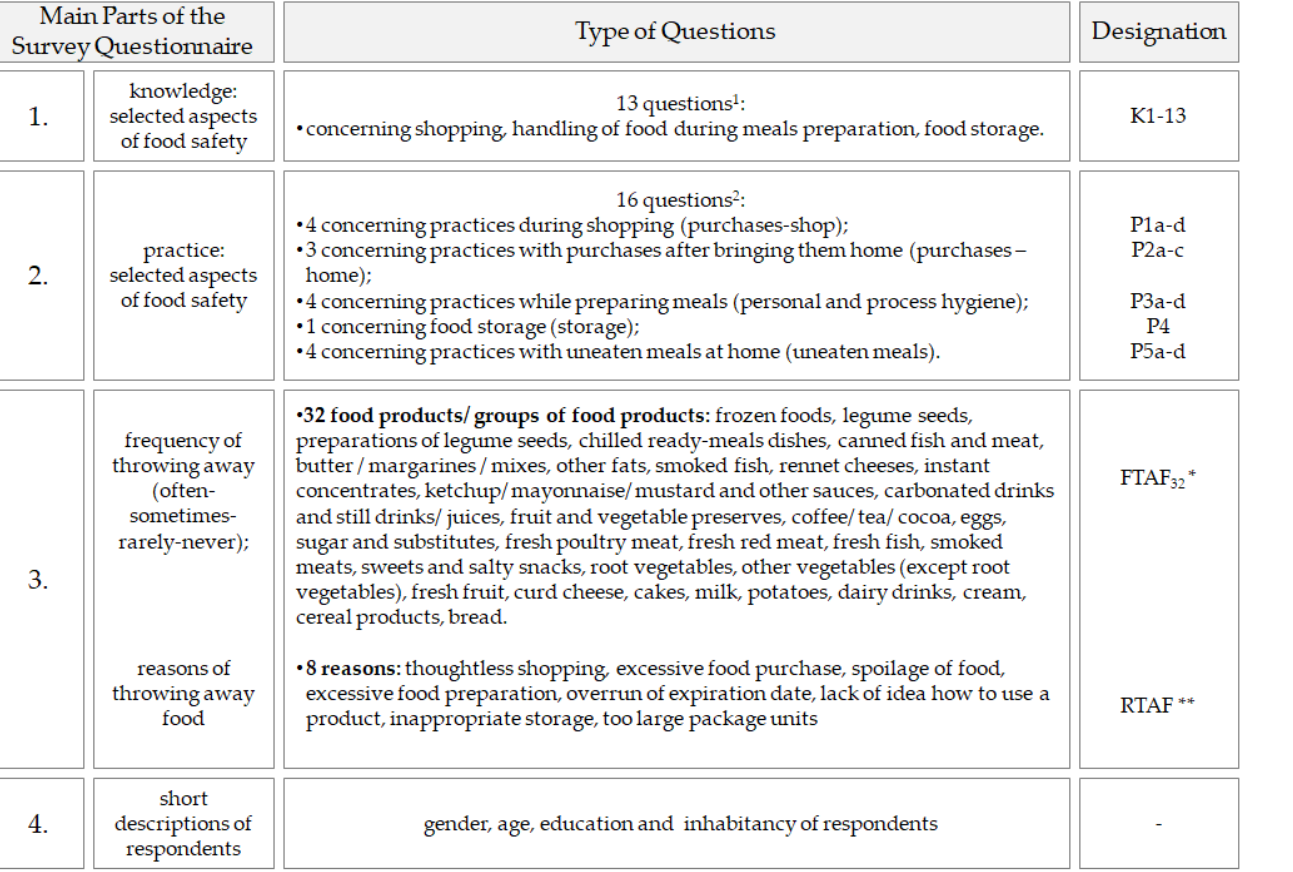
Figure 3. Division of the questionnaire into four parts with the adopted designation. 1 Appendix A— Table A1; 2 Appendix A—Tables A2 and A3; * FTAF 32 —Frequency of Throwing Away Food; ** RTAF—Reasons of Throwing Away Food.